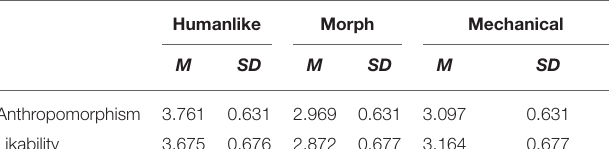
game, and task performance (i.e., score at the game) as dependent TABLE 4 | Mean ( M ) and standard deviation ( SD ) of the different perceptual variables. Results disclosed a significant main effect of dimensions (Q3) per level of humanlikeness. Manipulation check: descriptive statistics (humanlikeness) Humanlike Morph Mechanical